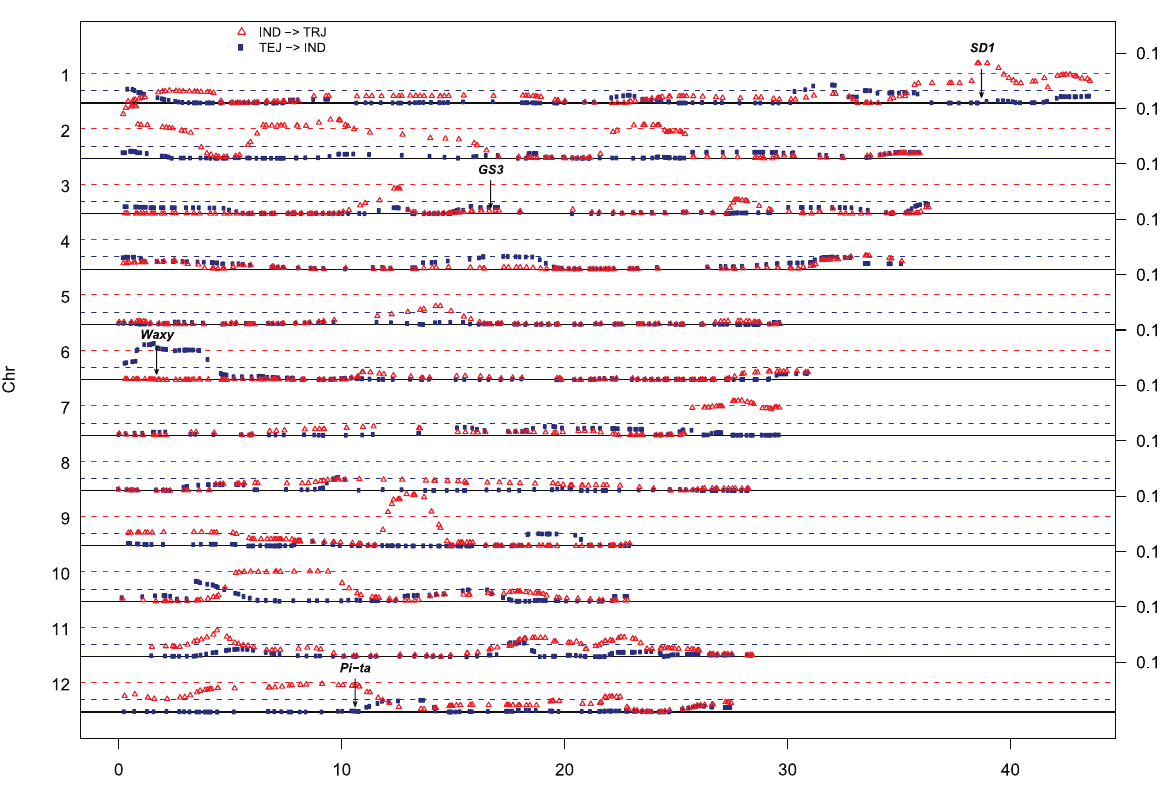
Figure 2. Average Introgression component in subpopulations. Each panel represents one chromosome and each SNP is represented as one point in the figure. Here we illustrate introgression from indica (IND ) into tropical japonica ( TRJ ) (red) and from temperate japonica (TEJ) into indica (IND) (dark blue). The dashed lines are the 5 th percentile of all the SNPs for each introgression with the same color. Four genes SD1 , GS3 , Waxy , Pi-ta located in or near peak regions are indicated along the genome.